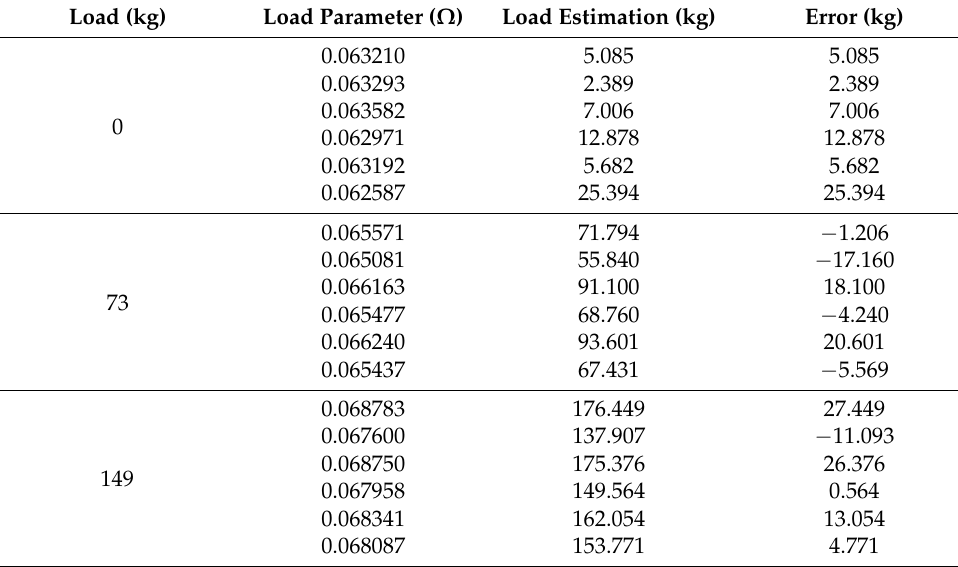
Table A3. Measurement data for Hyundai ix35 test